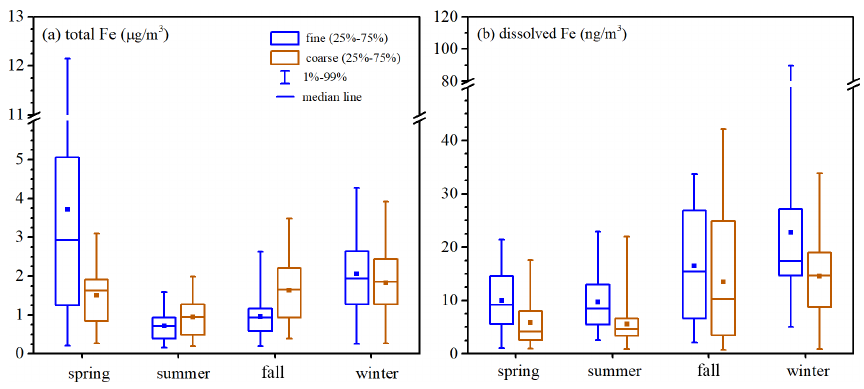
Figure 1. Seasonal variations of (a) total Fe and (b) dissolved Fe for fine and coarse